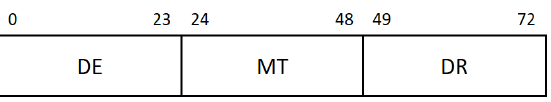
Figure 5. Solution representation of GA in case study